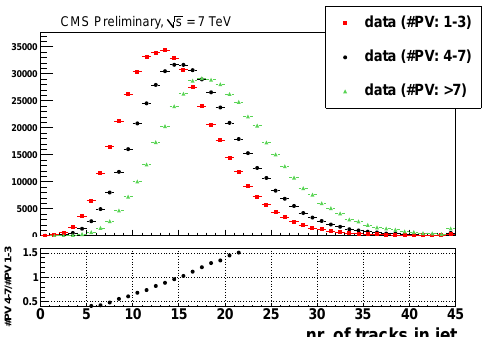
Fig. 1. Number of tracks associated to a jet without any selection cut.